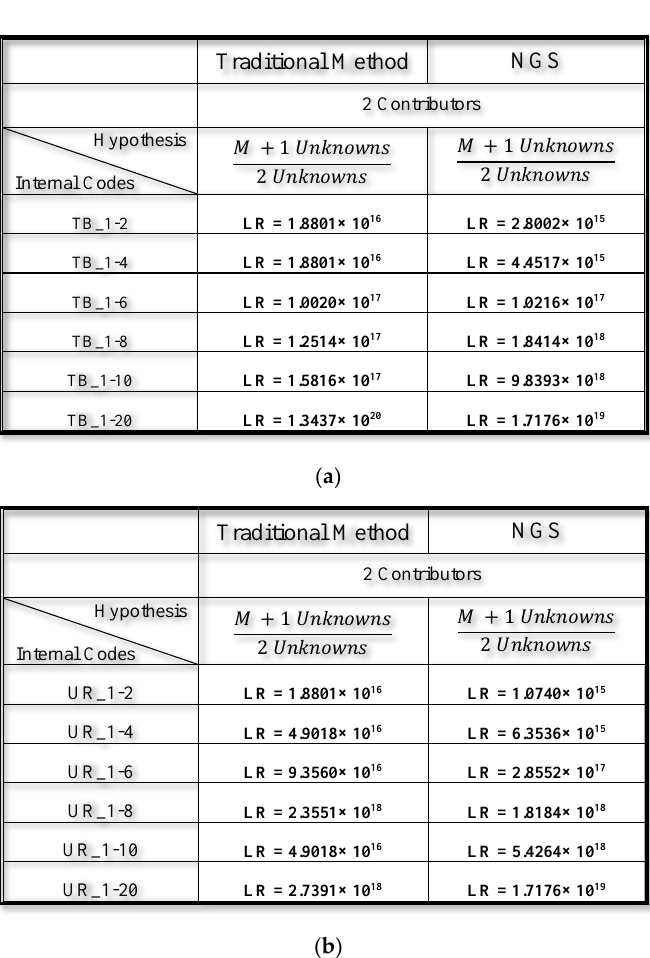
Figure 5. ( a ) Biostatistical and comparative analysis aimed at evaluating the inclusion or exclusion of the major contributor (M) in the mixtures coming from buccal swab sample (semicontinuous method); ( b ) biostatistical and comparative analyses aimed at evaluating the inclusion or exclusion of the major contributor (M) in the mixtures coming from urine samples (semicontinuous method).